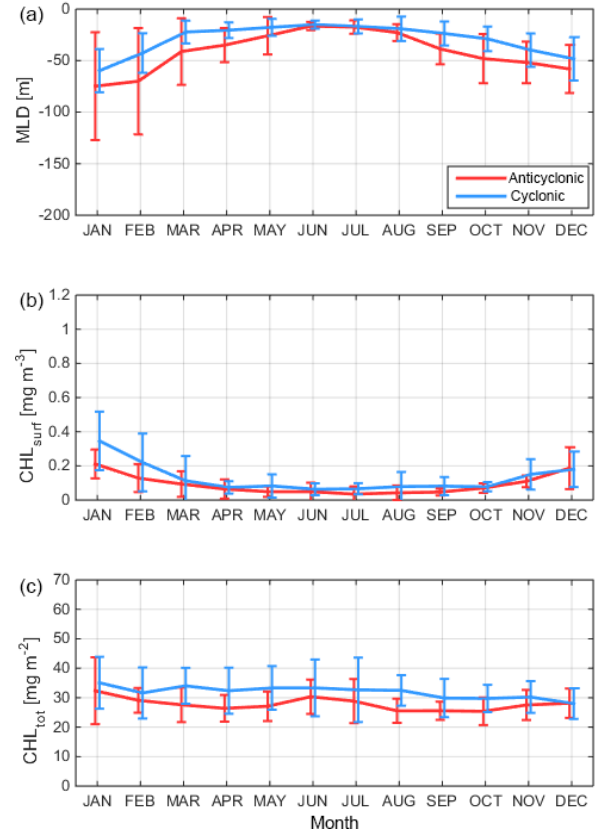
Figure 5. Basin-scale, monthly climatological mean and standard deviation of: (a) the mixed-layer depth, (b) surface chlorophyll and (c) integrated chlorophyll over the first 350m. Red (blue) shows statistics for all profiles in anticyclonic (cyclonic)